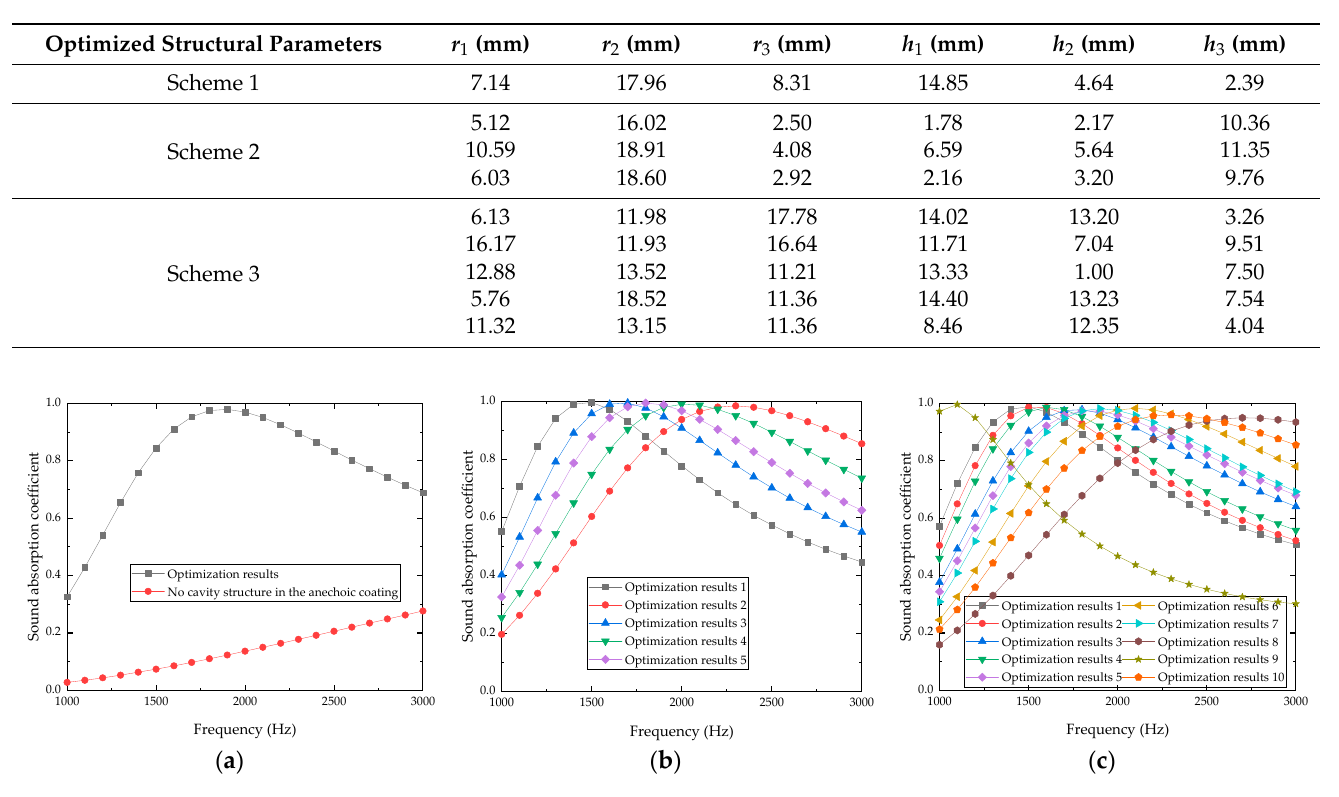
Table 4. Optimized parameters.